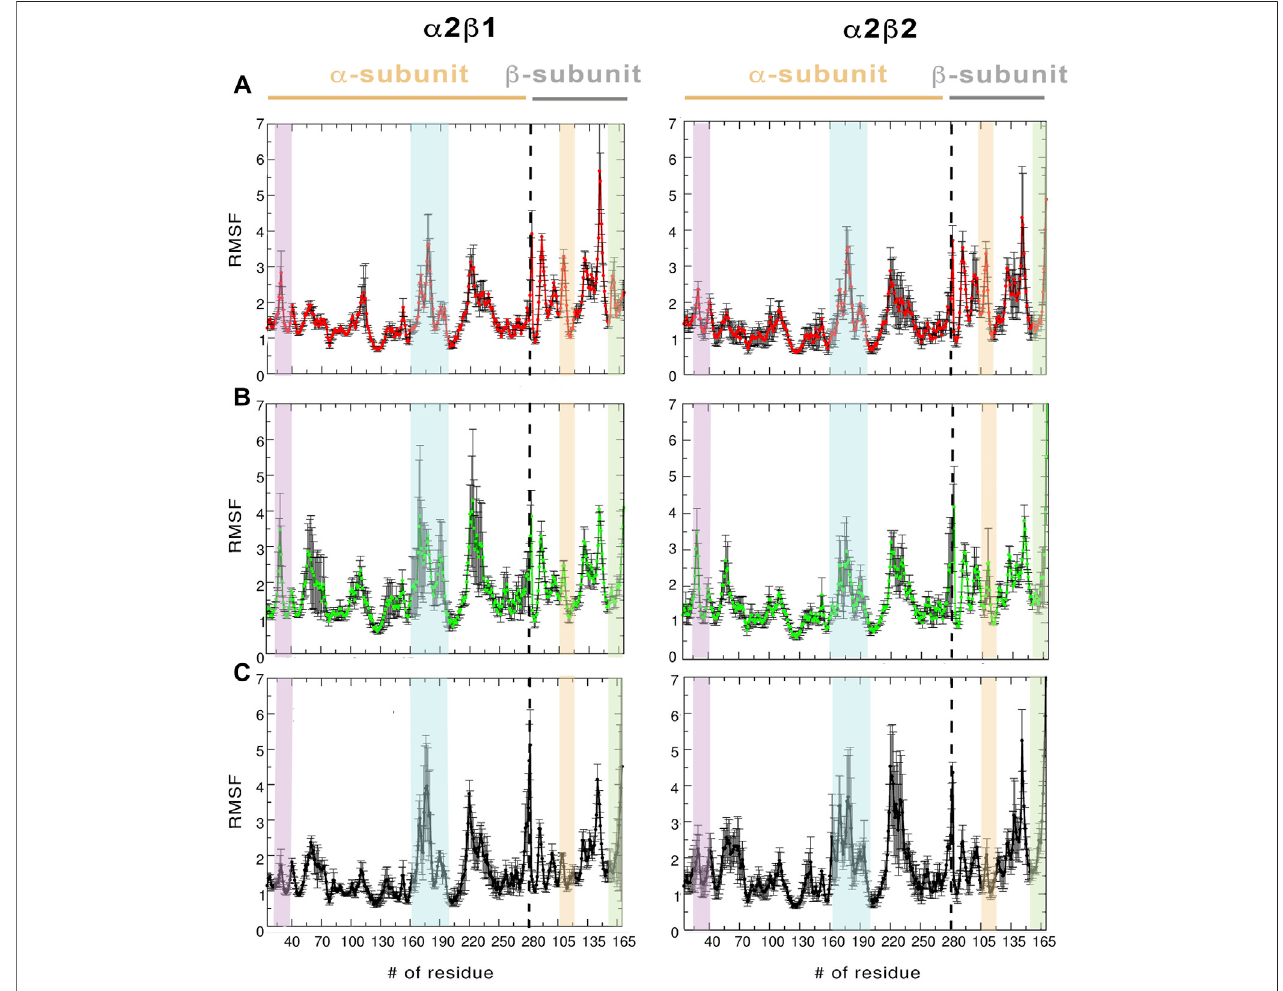
FIGURE3| RMSF(Å)averageoftheresiduesdeterminedfortheproteinbackbonealongthelast500 nsofthethreeindependentreplicasrunsfor (A) apo, (B) holo and (C) holo+ATP. The standard deviation for each residue is shown as an error bar. The highlighted regions denote the moieties corresponding to P-loop (purple) , activation loop (cyan) , CBM domain (orange) , and C-interacting helix (green)